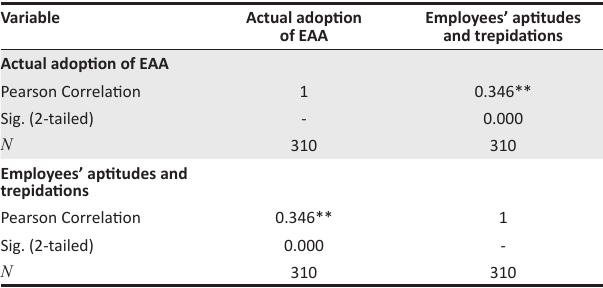
FIGURE 2. Normal distribution indicates an asymmetric distribution with acquiescent tails. The mean, median and mode are all equivalent @ 40.95. σ = 6.211. N = TABLE 3: Pearson correlations.